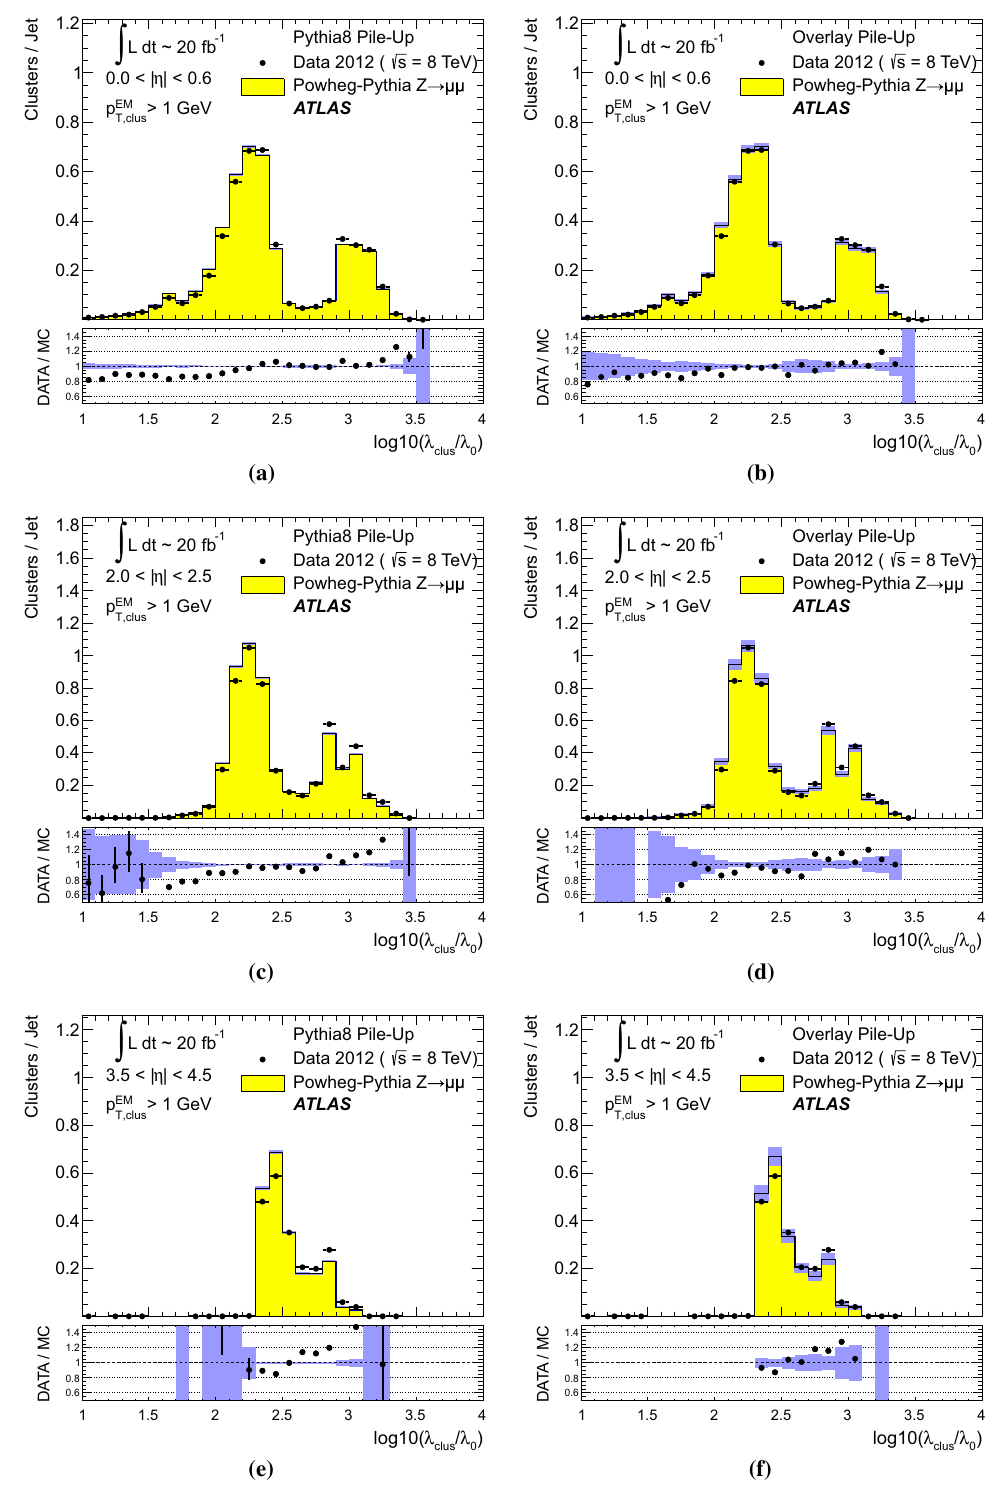
Fig. 35 The distribution of the depth location, measured in terms of central ( | η | < 0 . 6), the ( c , d ) end-cap (2 . 0 < | η | < 2 . 5), and the ( e , > 1GeV f ) forward detector region (3 . 5 < | η | < 4 . 5). The data-to-MC simula- log 10 (λ clus /λ 0 ) with λ 0 = 1mm, of topo-clusters with p EM T , clus tion ratios are shown below the distributions. The shaded bands shown in jets reconstructed with the anti- k t algorithm with R = 0 . 4 and with < 40GeV in Z → μμ events in 2012 data and for the distributions obtained from MC simulations indicate statistical 30GeV < p LCW + JES T , jet uncertainties and the corresponding uncertainty bands in the ratio MC simulations with ( a , c , e ) fully simulated pile-up and with ( b , d , f ) overlaid pile-up from data. Distributions are shown for jets in the ( a , b )